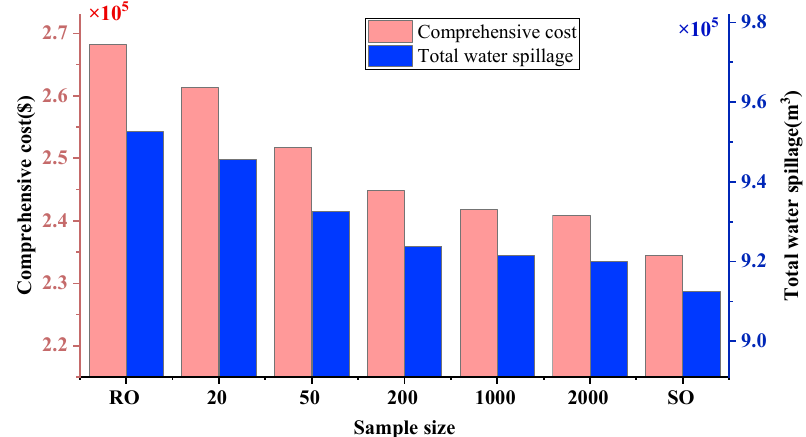
Figure 7. Test results under DR-DOPF, RO, and SO methods.